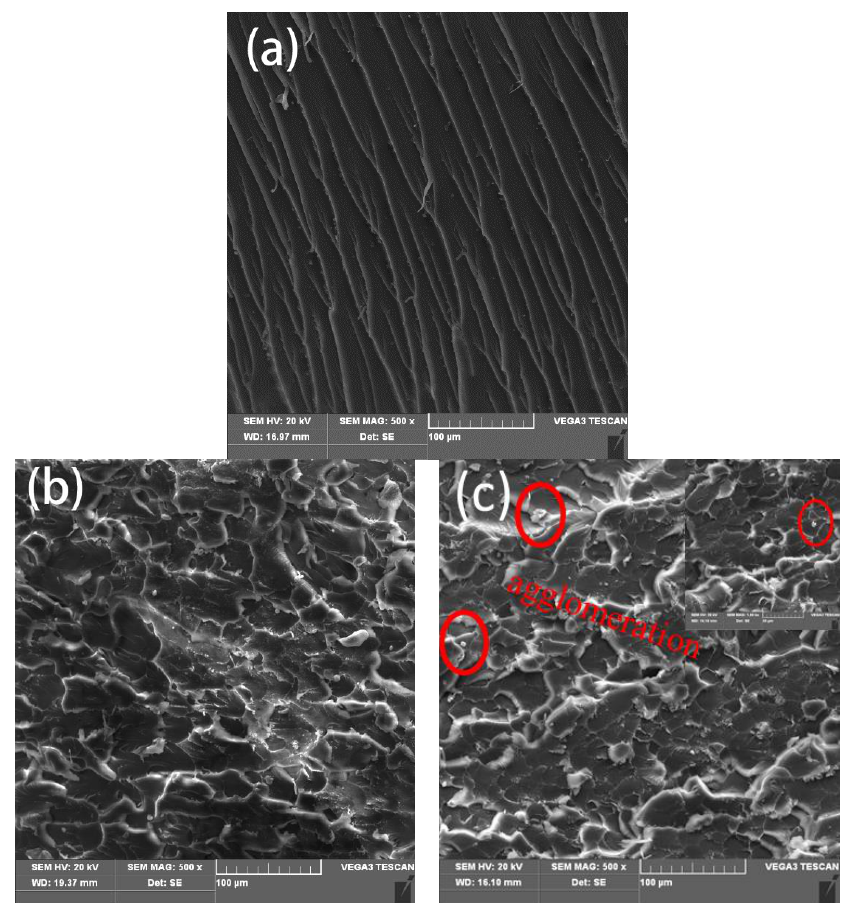
Figure 6. SEM images of the fracture surfaces of ( a ) the neat BMI ( b ) the composite with 0.6 wt % NH 2 -rGO/WS 2 and ( c ) the composite with 1.0 wt % NH 2 -rGO/WS 2 .